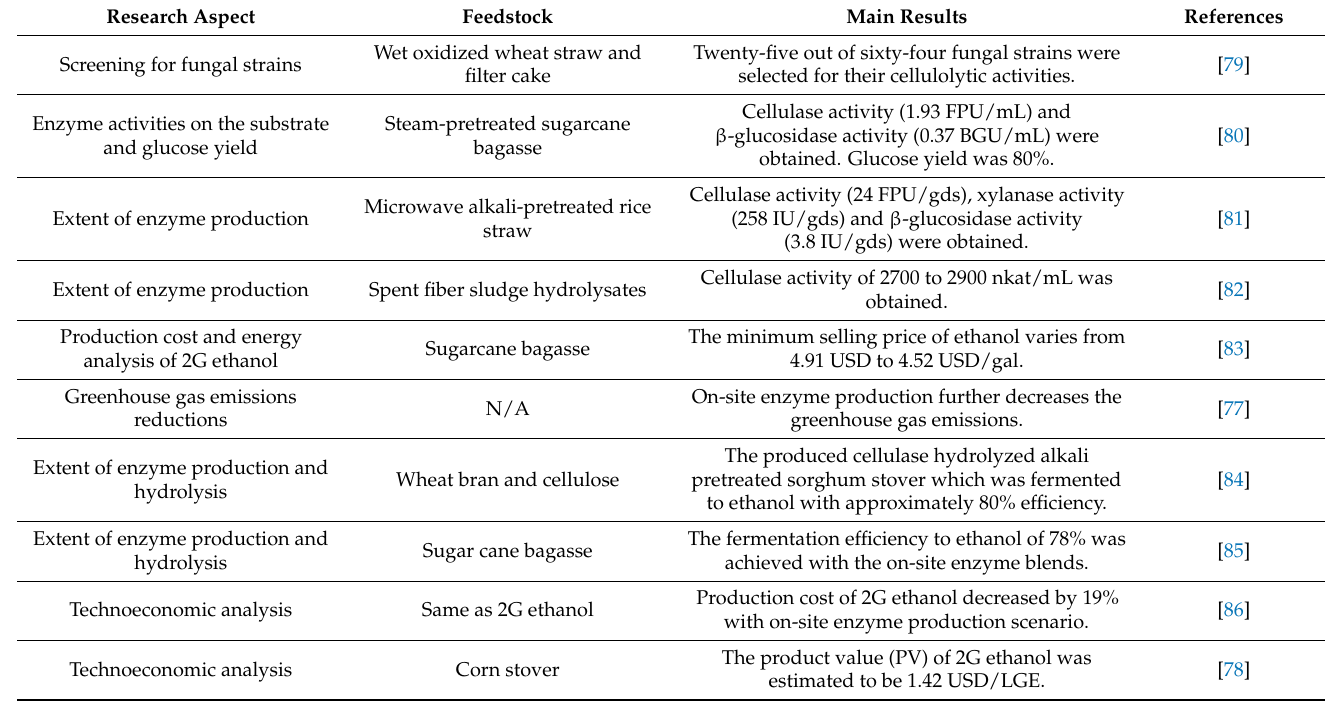
Table 3. Studies conducted to analyze the potential of on-site enzyme production for 2G